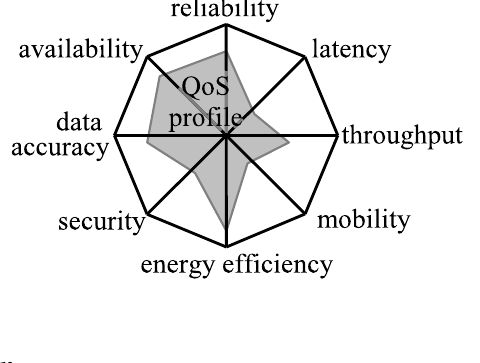
Figure 2. Quality of service (QoS) parameters in WSNs. The shown network QoS profile emphasizes reliability, availability, data accuracy, and